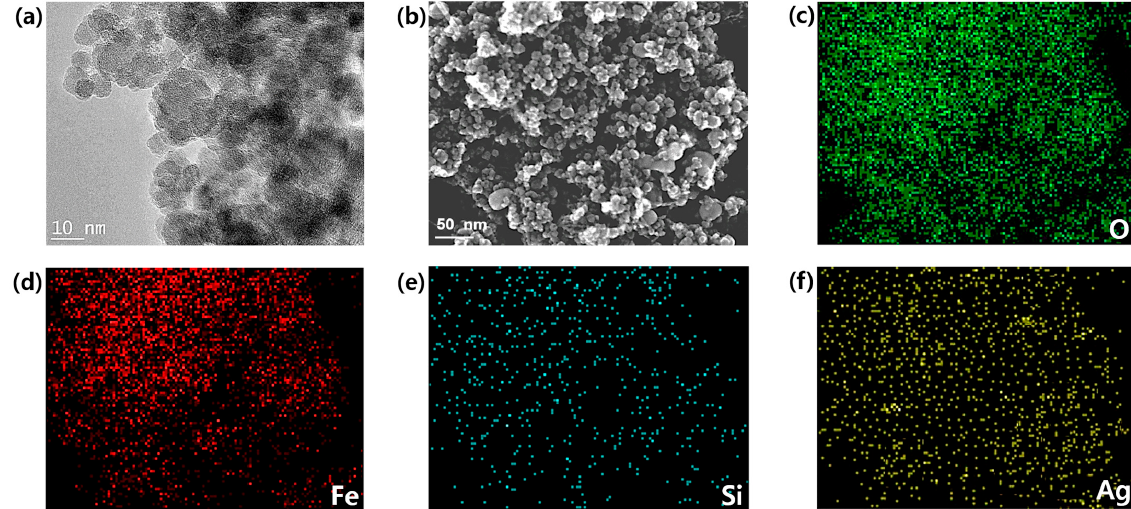
Figure 2. ( a ) TEM images of the Ag/Fe 3 O 4 composite nanoparticles, ( b ) SEM image of the Ag/Fe 3 O 4 composite nanoparti- cles, ( c – f ) EDS elemental mapping patterns of the Ag/Fe 3 O 4 nanocomposites from ( b ).